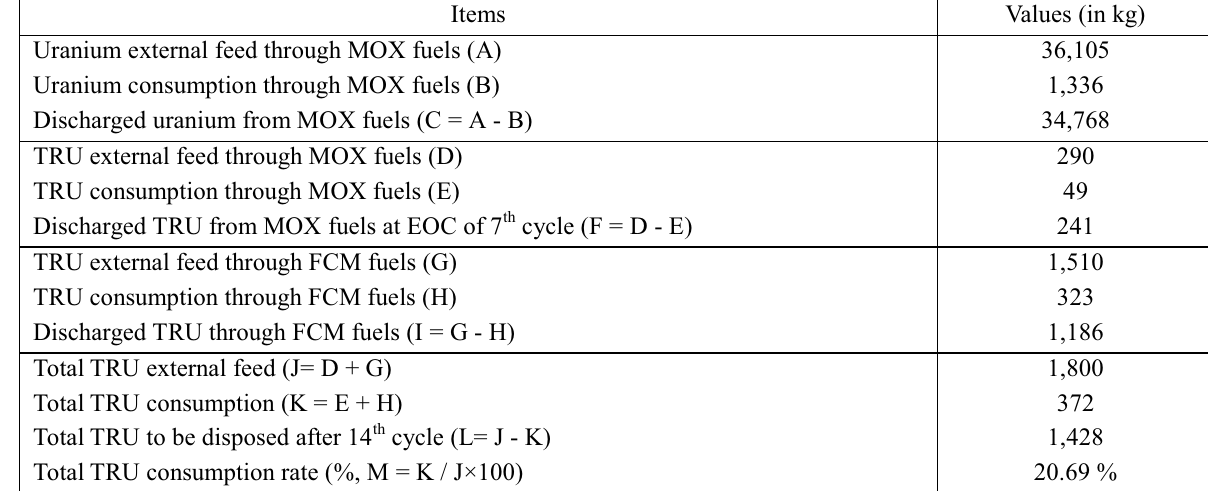
Table V. Overall mass balance of U and TRU from 5 th to 14 th cycle calculated by McCARD/MASTER two - step